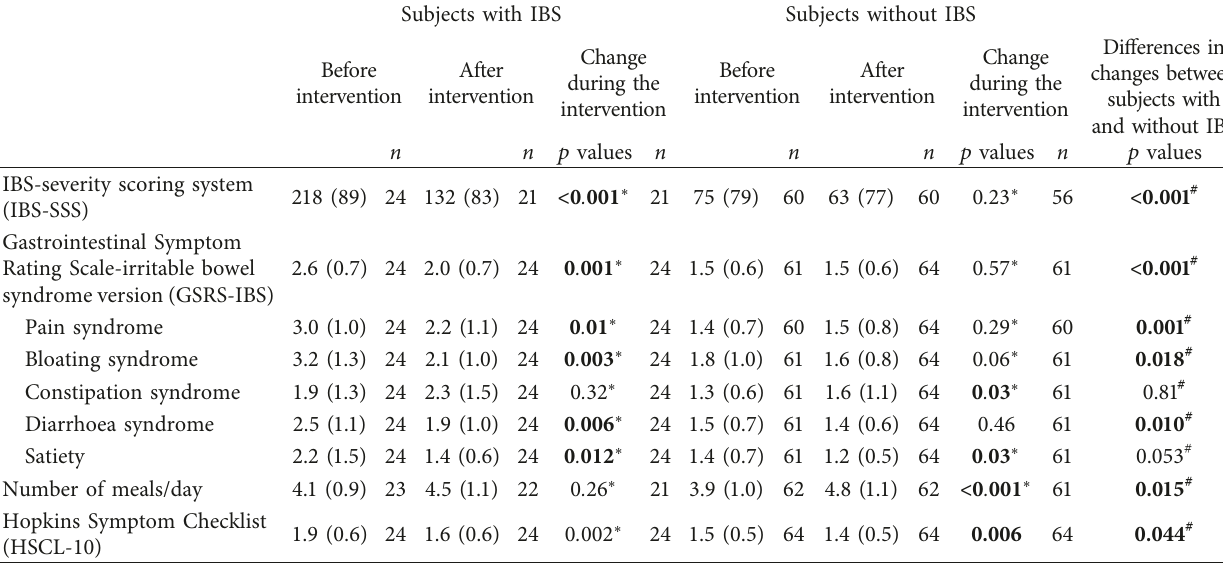
Table 4: Subjects’ characteristics before and after the conservative weight loss intervention, stratified by IBS status before the intervention.